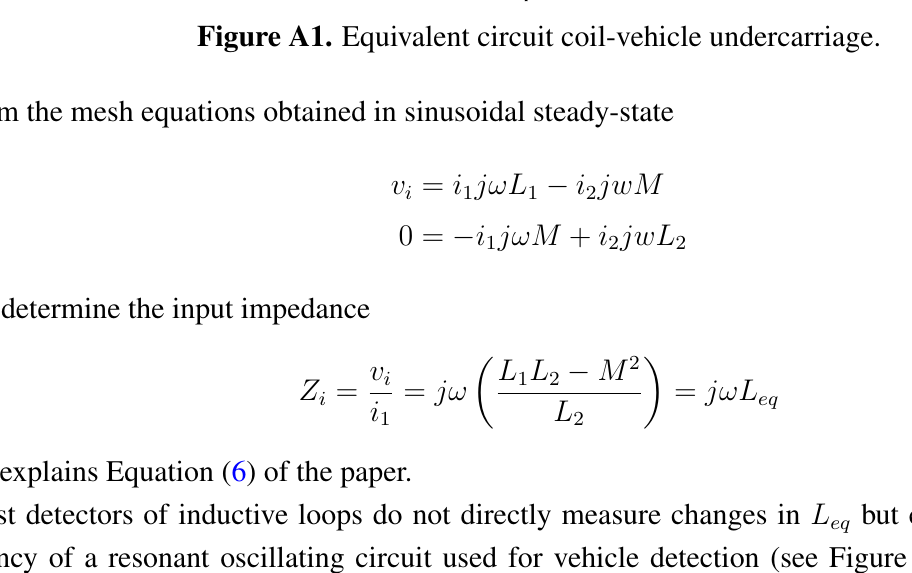
Figure A2. Resonant oscillation circuit used for vehicle